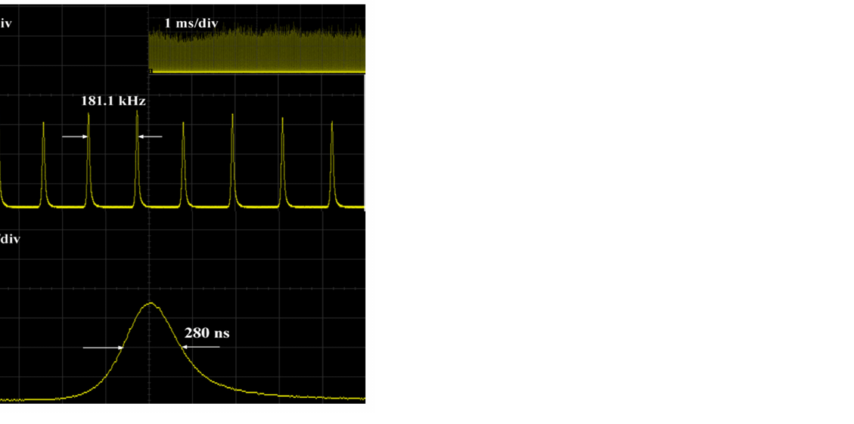
Figure 6. ( a ) The Q-switched pulse trains; ( b ) the single pulse under the absorbed pump power of 5.45 W.